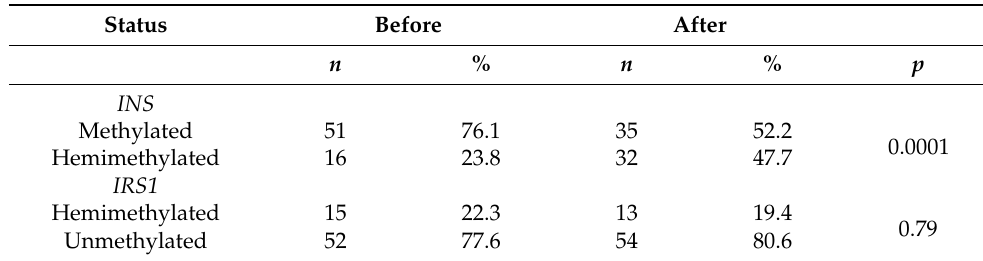
Table 2. Methylation status of the INS and IRS1 genes before and after inulin intervention in T2DM patients.